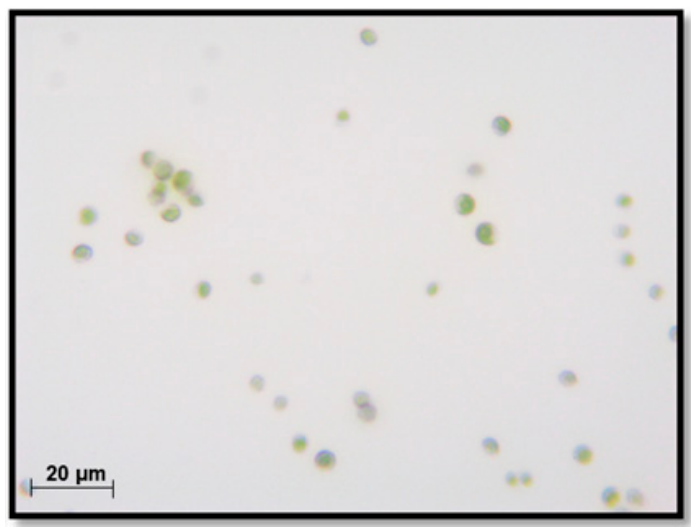
Figure 7. Microscopic images (×1000 time magnification) of the control algal FS.